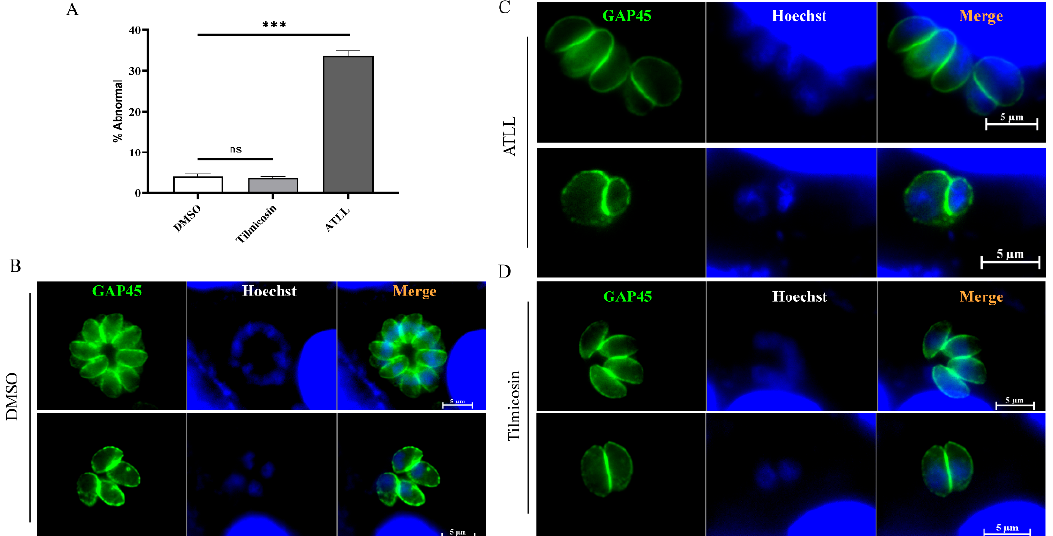
Figure 5. Abnormal morphology of tachyzoites due to ATLL. ( A ) Abnormal division of T. gondii after tilmicosin or ATLL treatment. 1 × 10 5 tachyzoites were used to invade HFF monolayers seeded on cover slips and then treated with DMSO ( B ), ATLL (16 μ M) ( C ) and tilmicosin (26.94 μ M) ( D ) at 37 °C in 5% CO 2 for 20 h, respectively. After 24 h post-treatment, the morphology of tachyzoites was observed by IFA using rabbit anti-GAP45 antibody and Hoechst dye. The proportion of vacuoles containing abnormally developed tachyzoites was calculated using fluorescent images of random fields. Statistical analysis was performed by Graph Pad Prism using Student’s t test. Asterisks indicate statistically significance. ns = not significant, and *** p < 0.001.